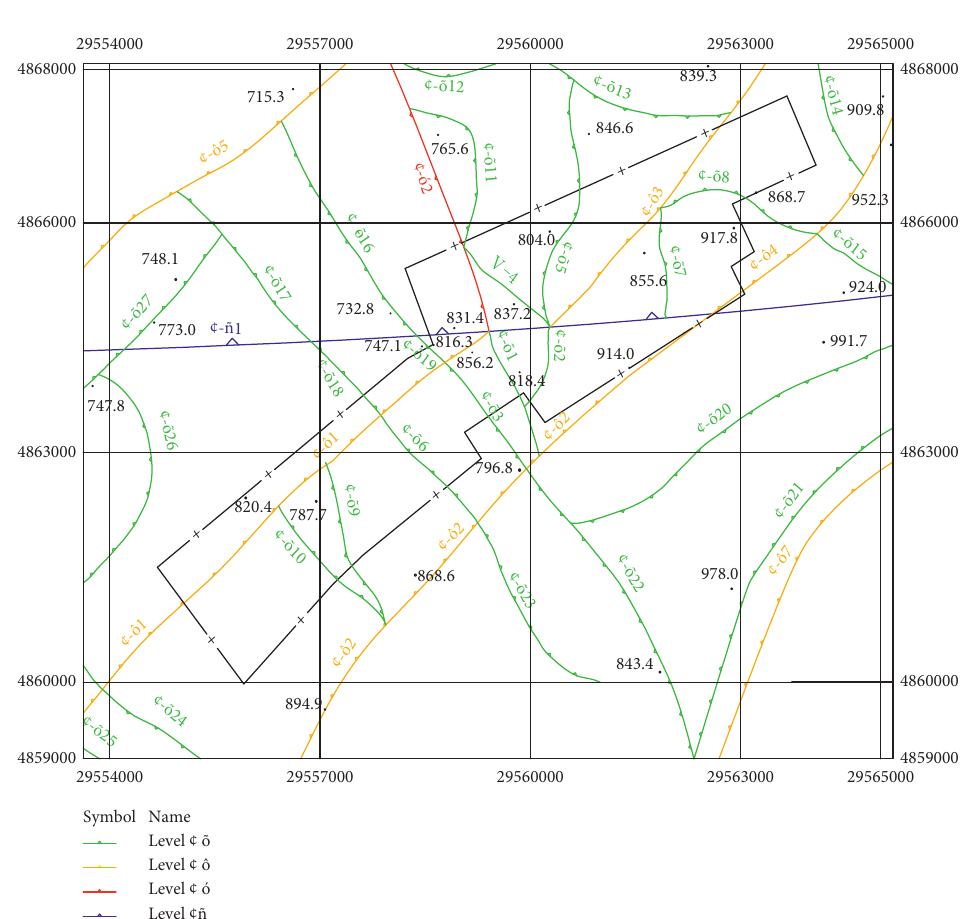
Figure 4: Grade V fault map of the Wudong minefield.